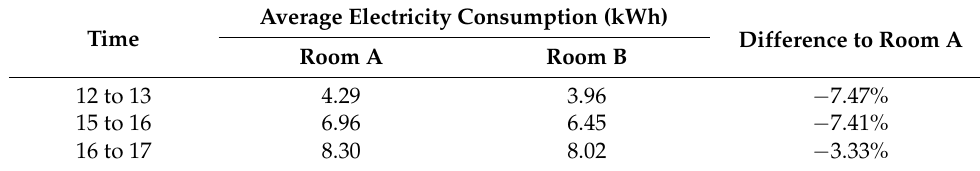
Table 4. Energy-saving efficiency at different time